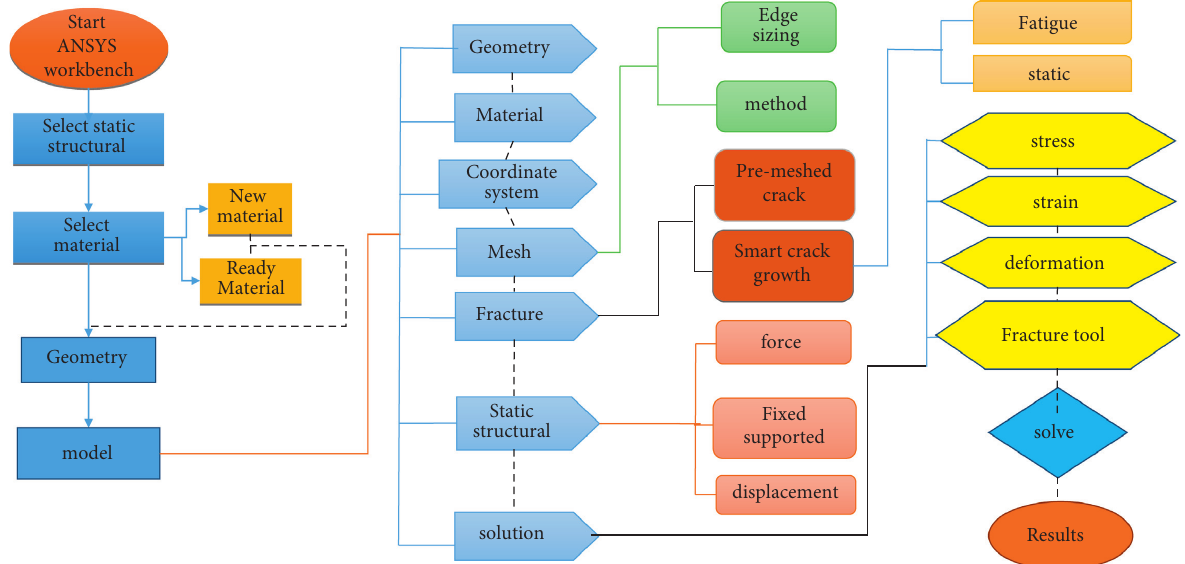
Figure 1: ANSYS flowchart for SMART crack